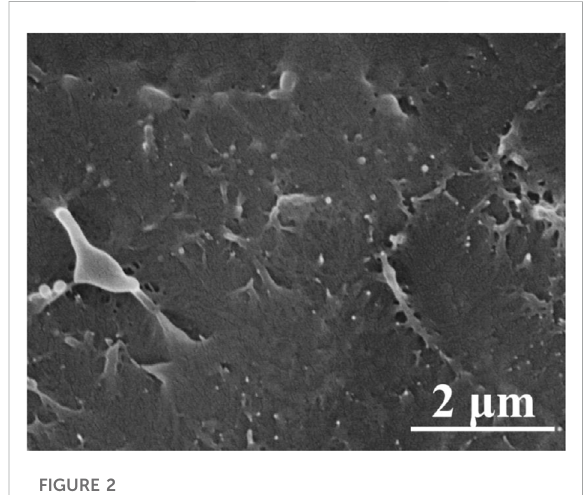
FIGURE 2 SEM images of PP/TiO 2 nanocomposites.